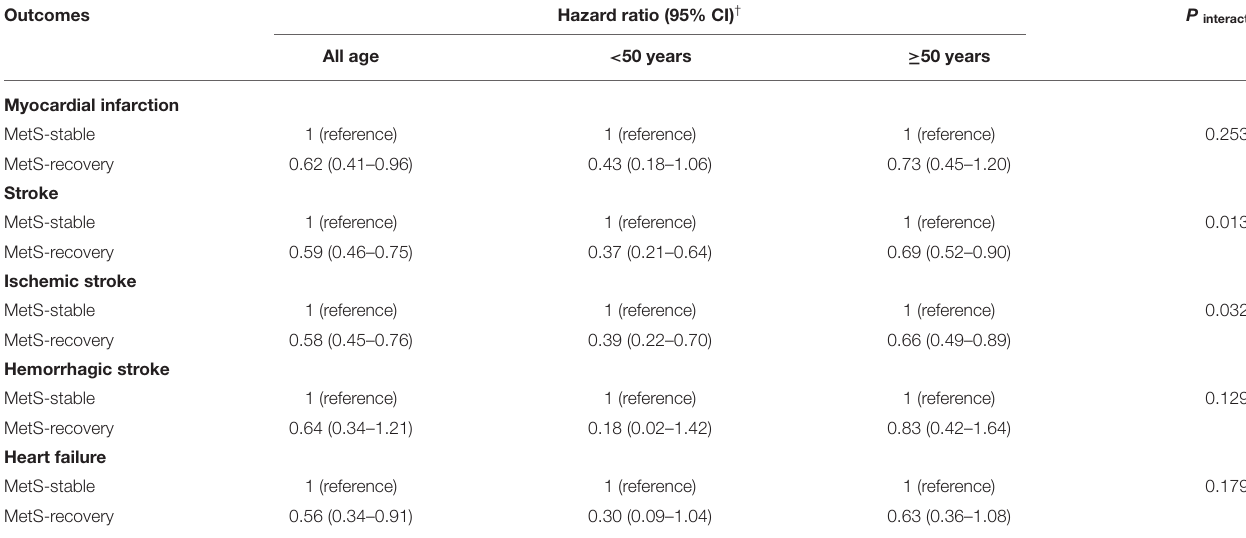
TABLE 4 | Hazard ratios and 95%CIs of the subtypes of cardiovascular disease in the MetS- recovery group according to the age of MetS